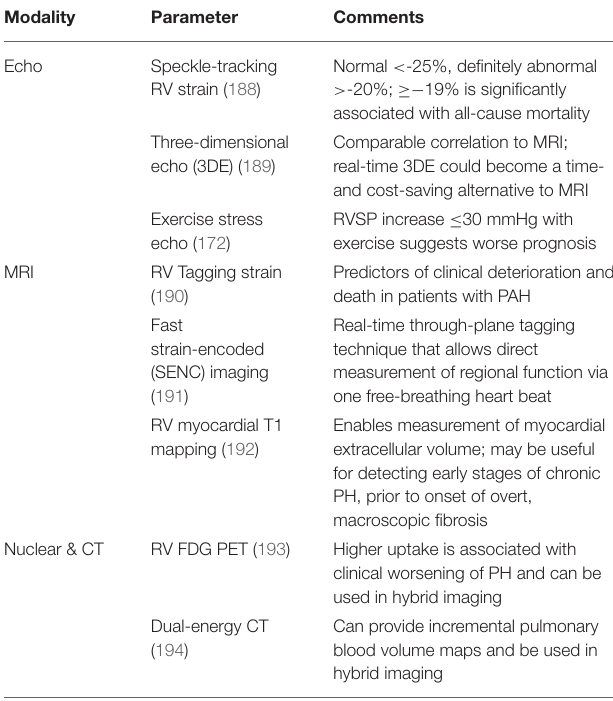
TABLE 3 | New non-invasive imaging techniques for pulmonary hypertension